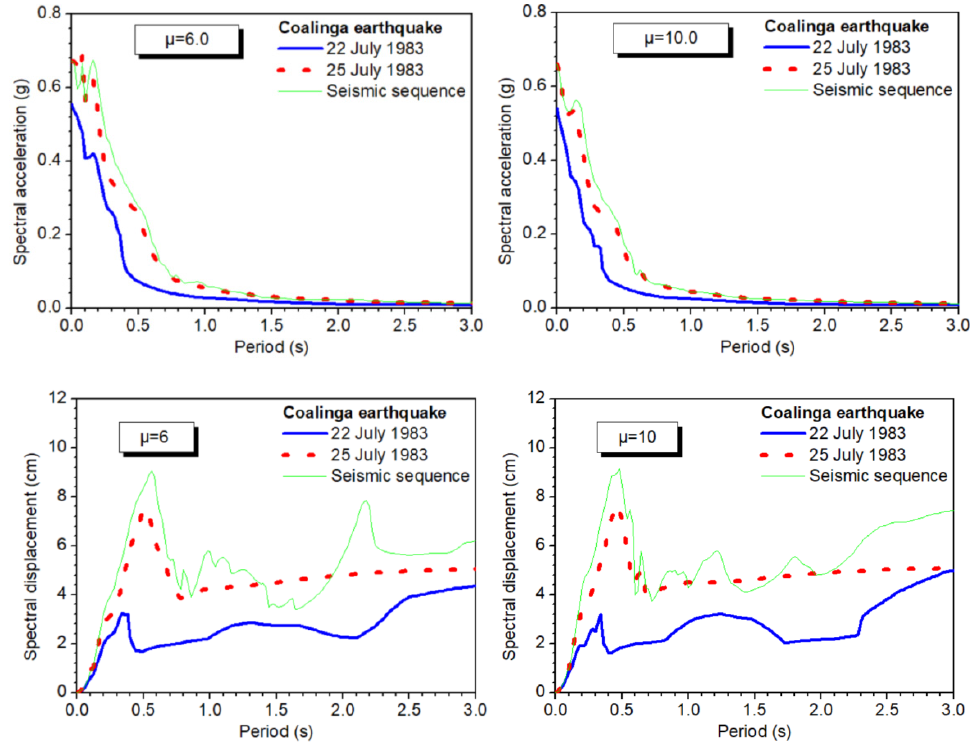
Figure 5. Constant-ductility acceleration and displacement spectra for the Coalinga earthquakes: μ =6 and μ = 10.